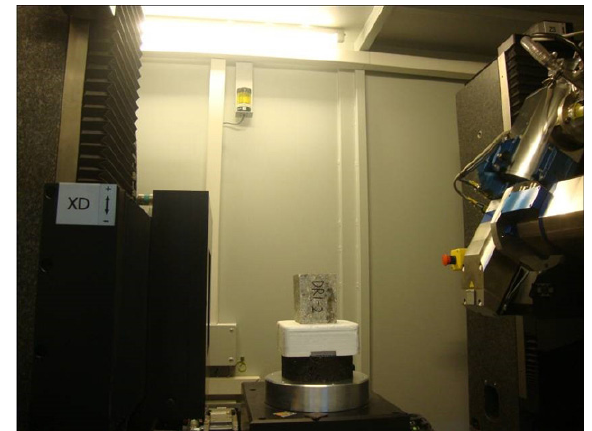
Fig. 7. Y. CT Precision S industrial CT scanner